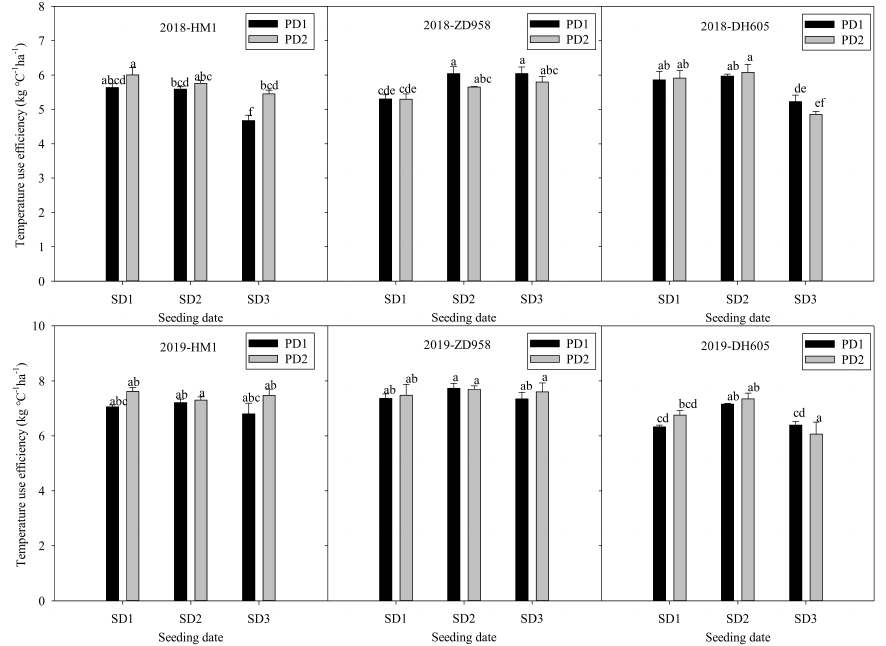
Figure 4. Effects of cultivar, sowing date and plant density on temperature use efficiency of summer maize. SD1, SD2, and SD3 represent the sowing dates of June 10, June 17, and June 24, respectively. PD1 and PD2 represent the plant densities of 6.75 × 10 4 plants ha − 1 and 8.25 × 10 4 plants ha − 1 , respectively. Different lowercase letters above the columns within one year indicate significant differences at p < 0.05.